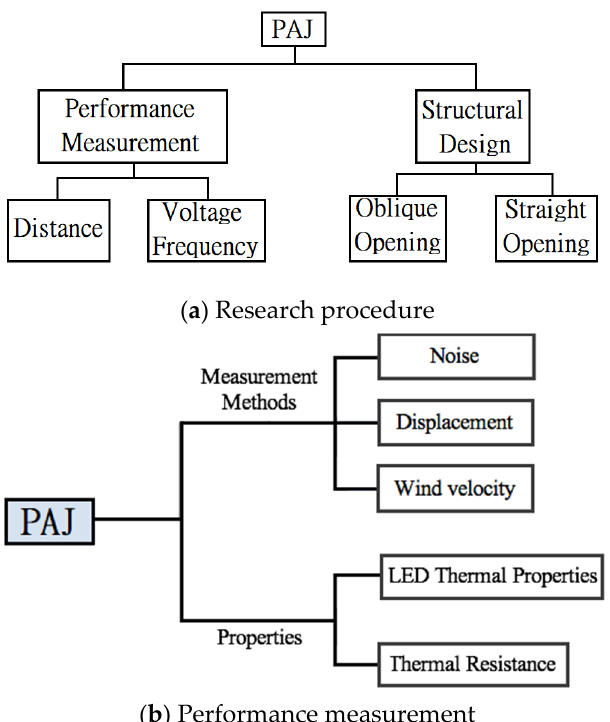
Figure 1. Experimental procedure. ( a ) Research procedure; ( b ) Performance